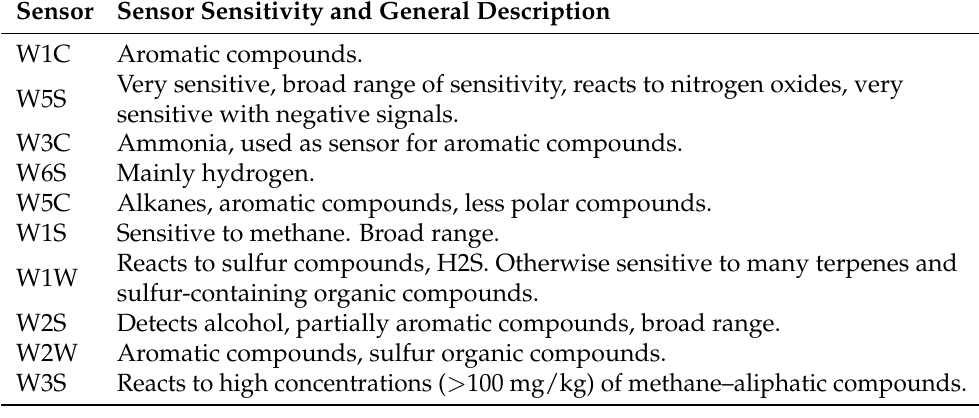
Table 2. Sensor array details in PEN-3 e-nose.